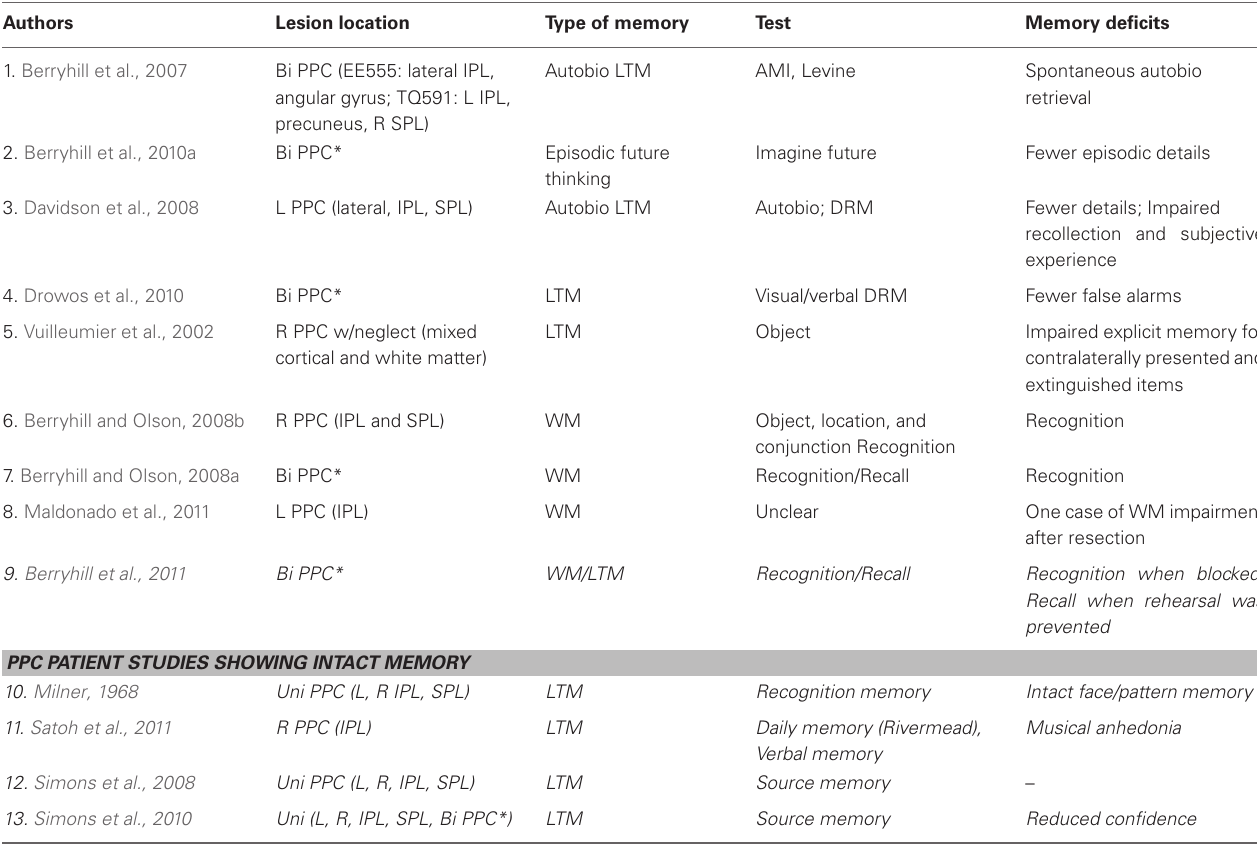
Table 1 | Summary of neuropsychological investigations of non-spatial episodic and working memory.